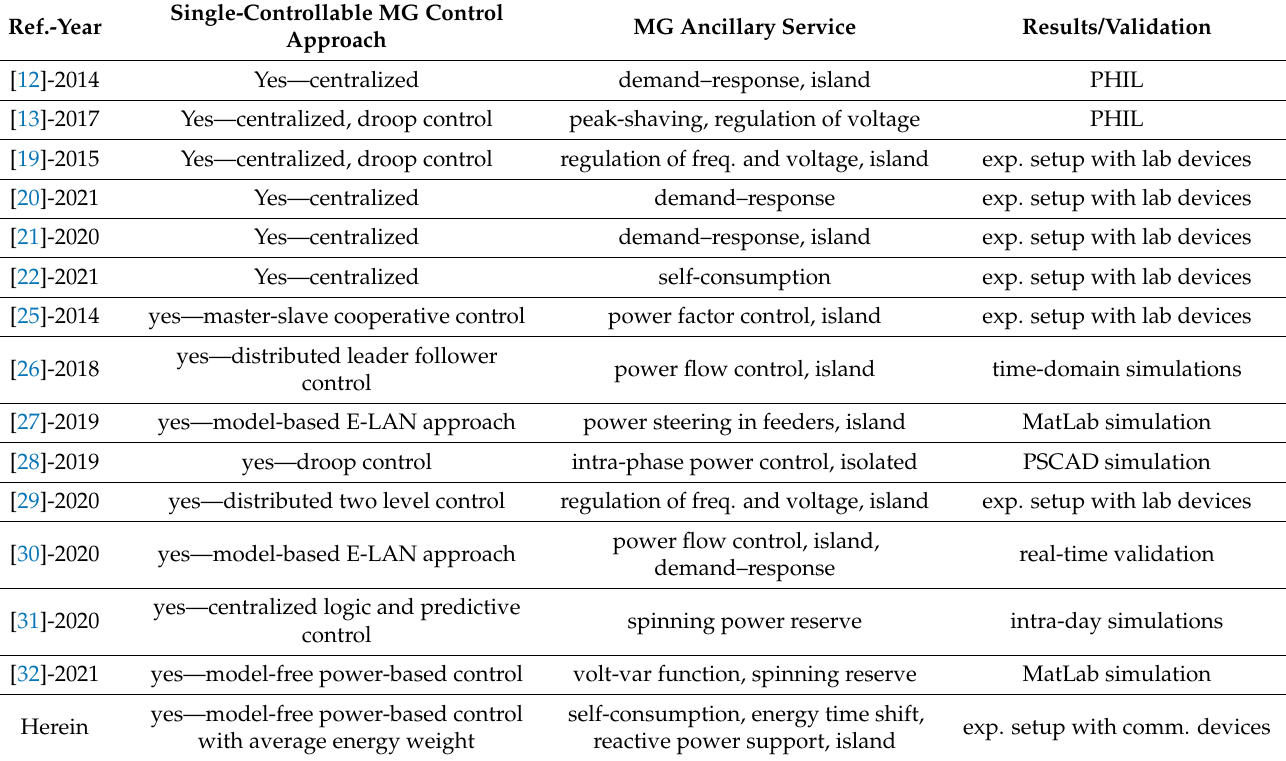
Table 1. Comparison between state-of-the-art single-controllable